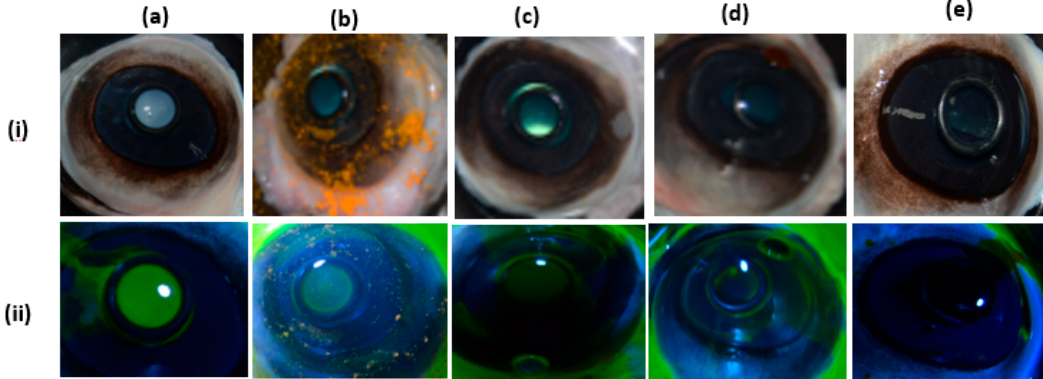
Figure 7. Photo-documentation of Bovine Cornea Opacity and Permeability (BCOP) assay results showing the two assessment criteria, degree of corneal opacity ( i ) and fluorescein permeability ( ii ), used to score. positive control ( a ), negative control ( e ) and test substances / formulations: curcumin powder ( b ), drug free in situ gelling insert ( c ) and curcumin loaded insert ( d ).